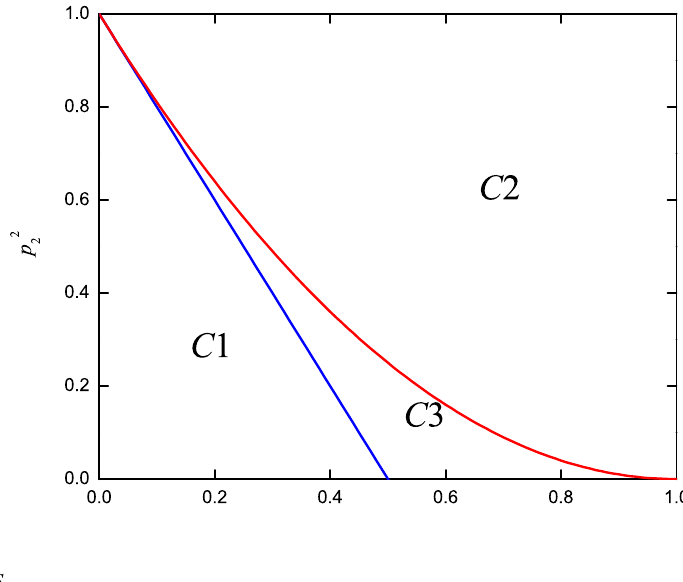
Figure 6. MIMO mode classification for the 2 × 2